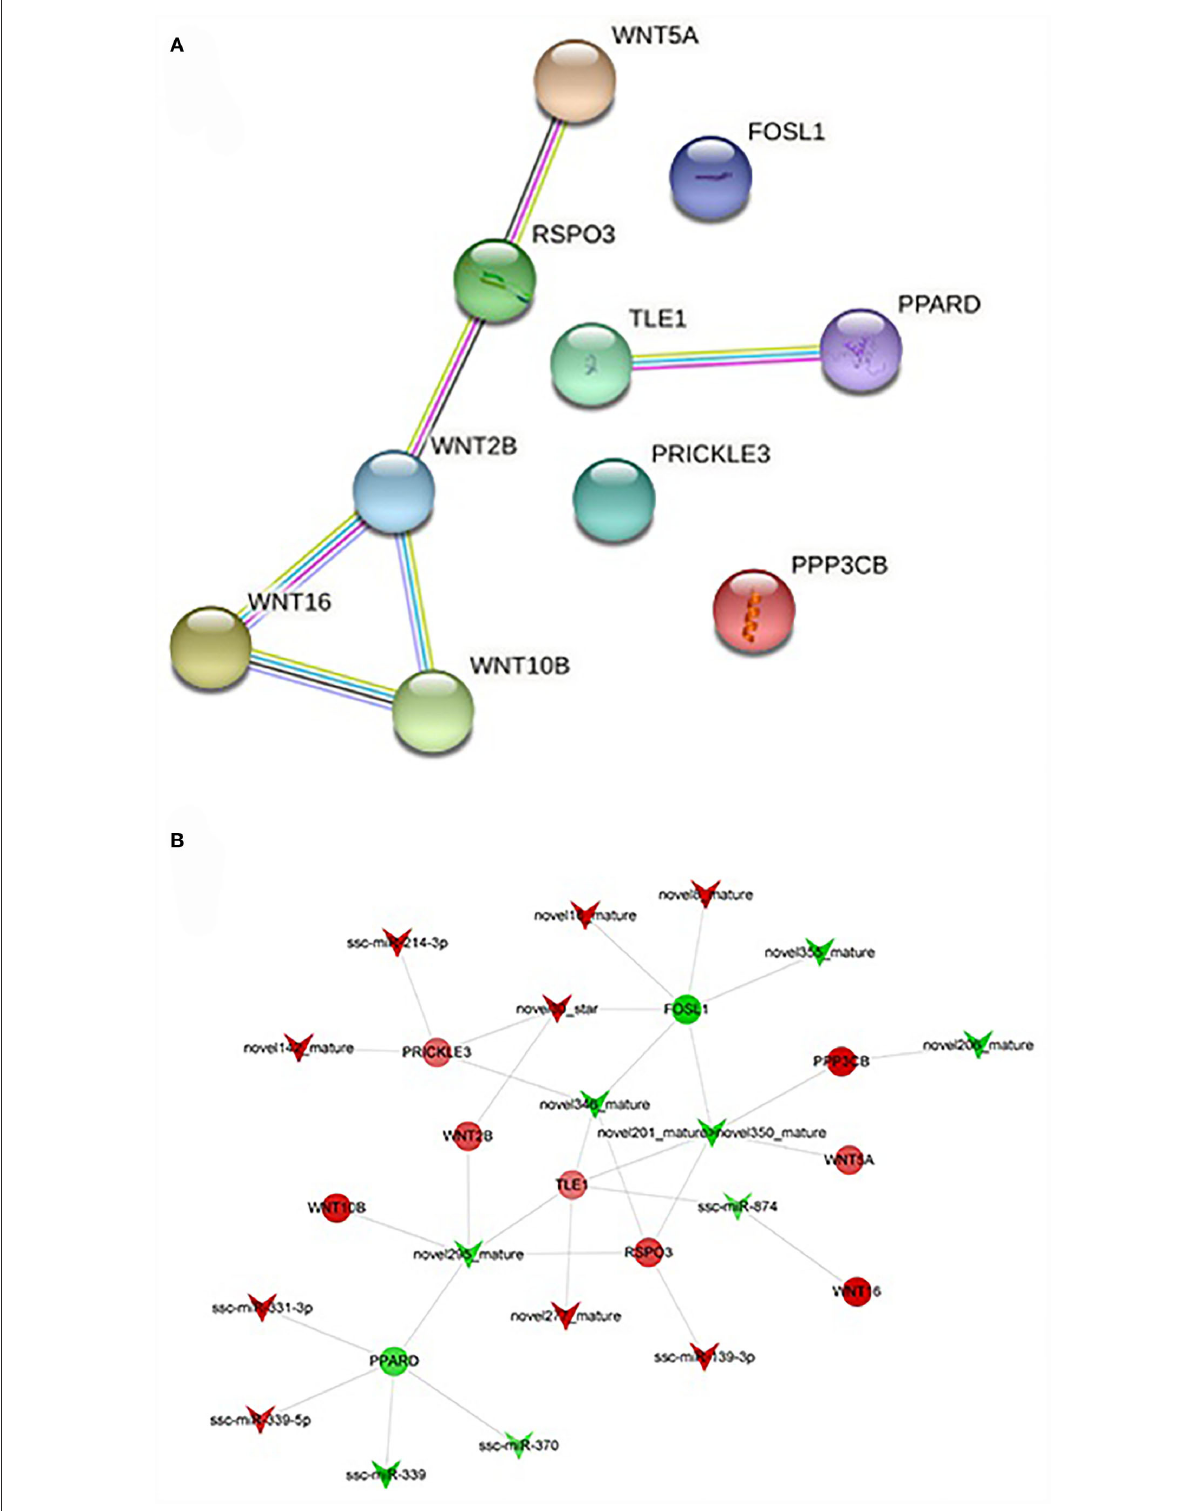
FIGURE6 (A) Protein-protein interaction network of differentially expressed gengs related to Wnt signaling pathway. (B) The targeting relationship of genes in regulation of Wnt signaling pathway.